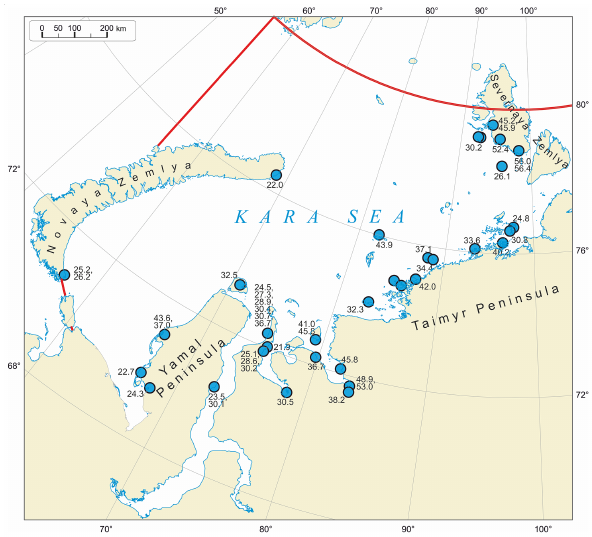
Figure 8. Location of onshore and offshore sections (points) with marine sediments ( 14 C – data, thousand years ago) of MIS-3 on the Kara Sea shelf, after Gusev et al. (2011, 2012a, b, 2013, 2016a, b), Baranskaya et al. (2018), Vasil‘chuk et al. (1984), Molodkov et al. (1987) and Bolshiyanov et al. (2009). The red line is the region boundary of this